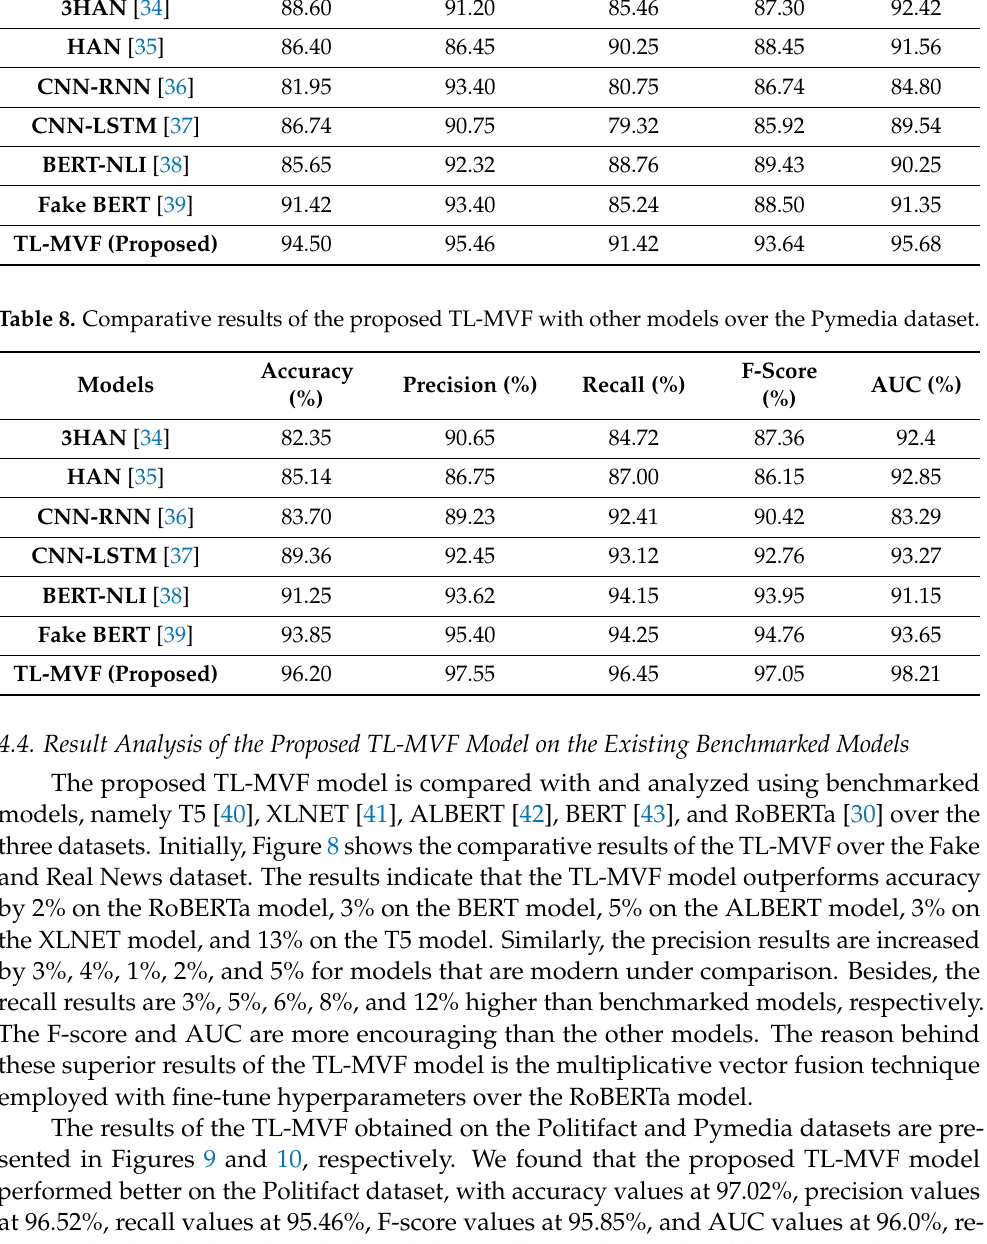
Table 7. Comparative results of the proposed TL-MVF with other models over the PolitiFact dataset. Models